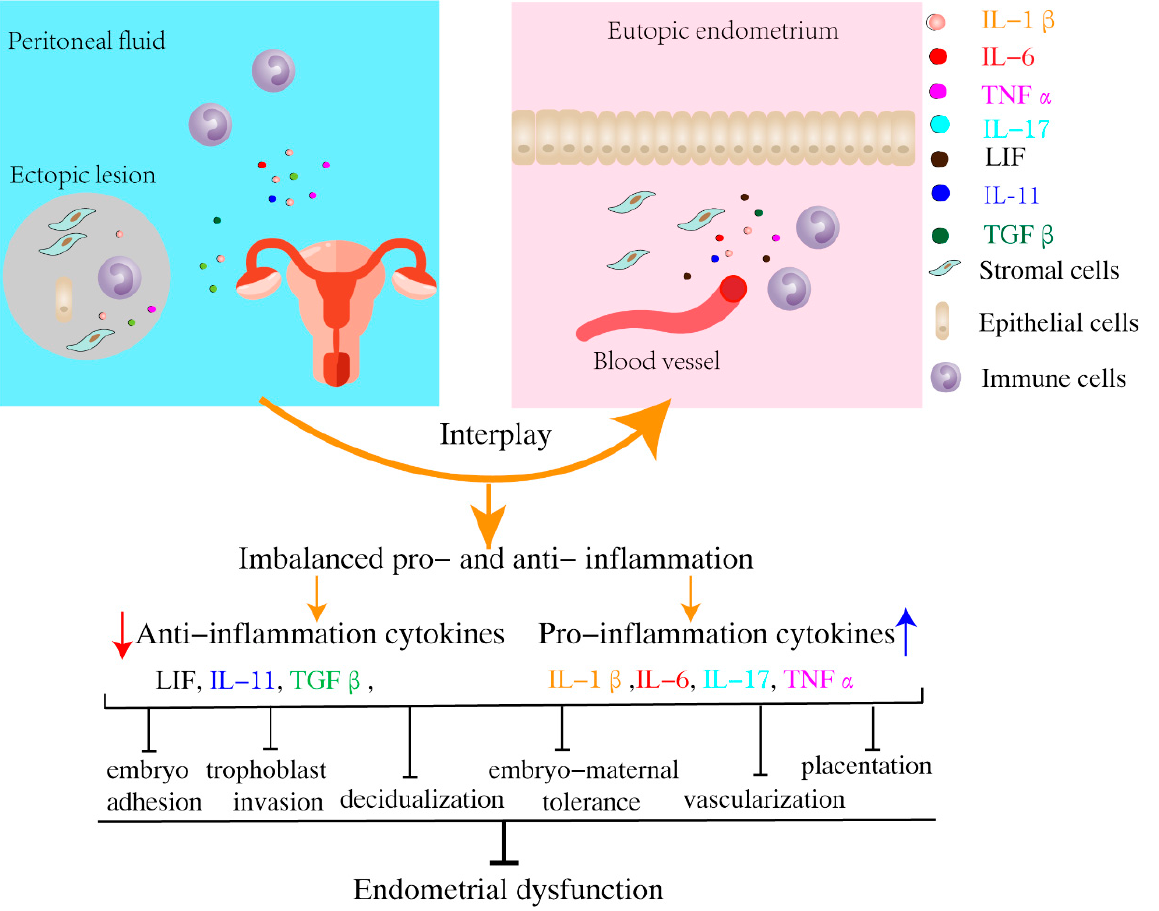
Figure 2. The effects of inflammation on endometrium in women with EMS. EMS, endometriosis; IL, interleukin; LIF, leukemia inhibitory factor; TGF, transforming growth factor; TNF, tumor necrosis factor.